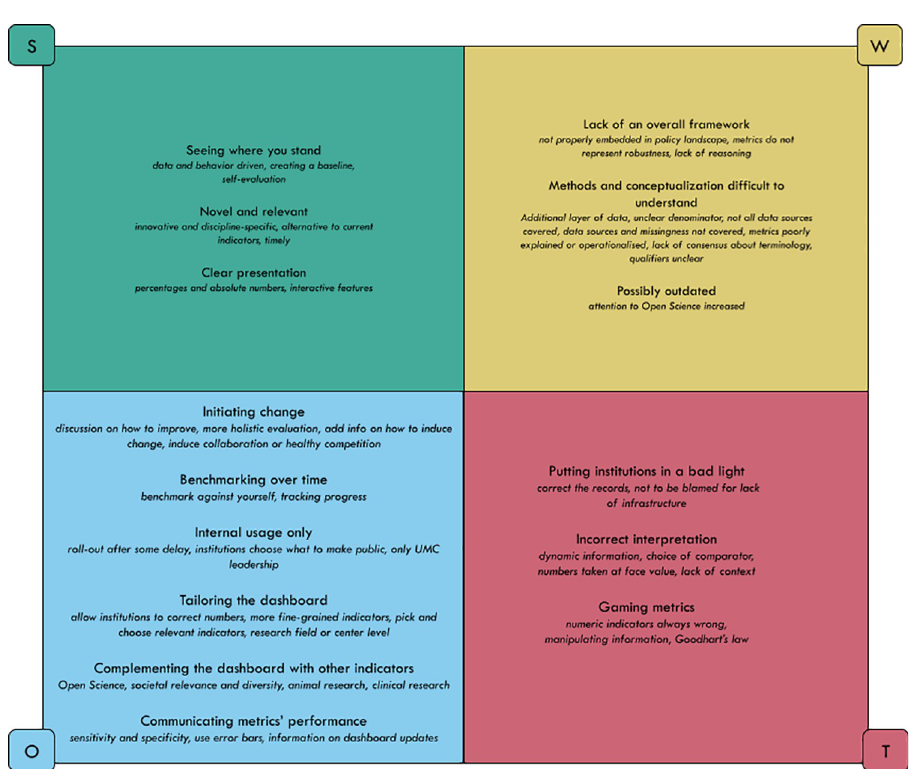
Fig 1. Overview of SWOTs regarding institutional dashboards with metrics for responsible research.